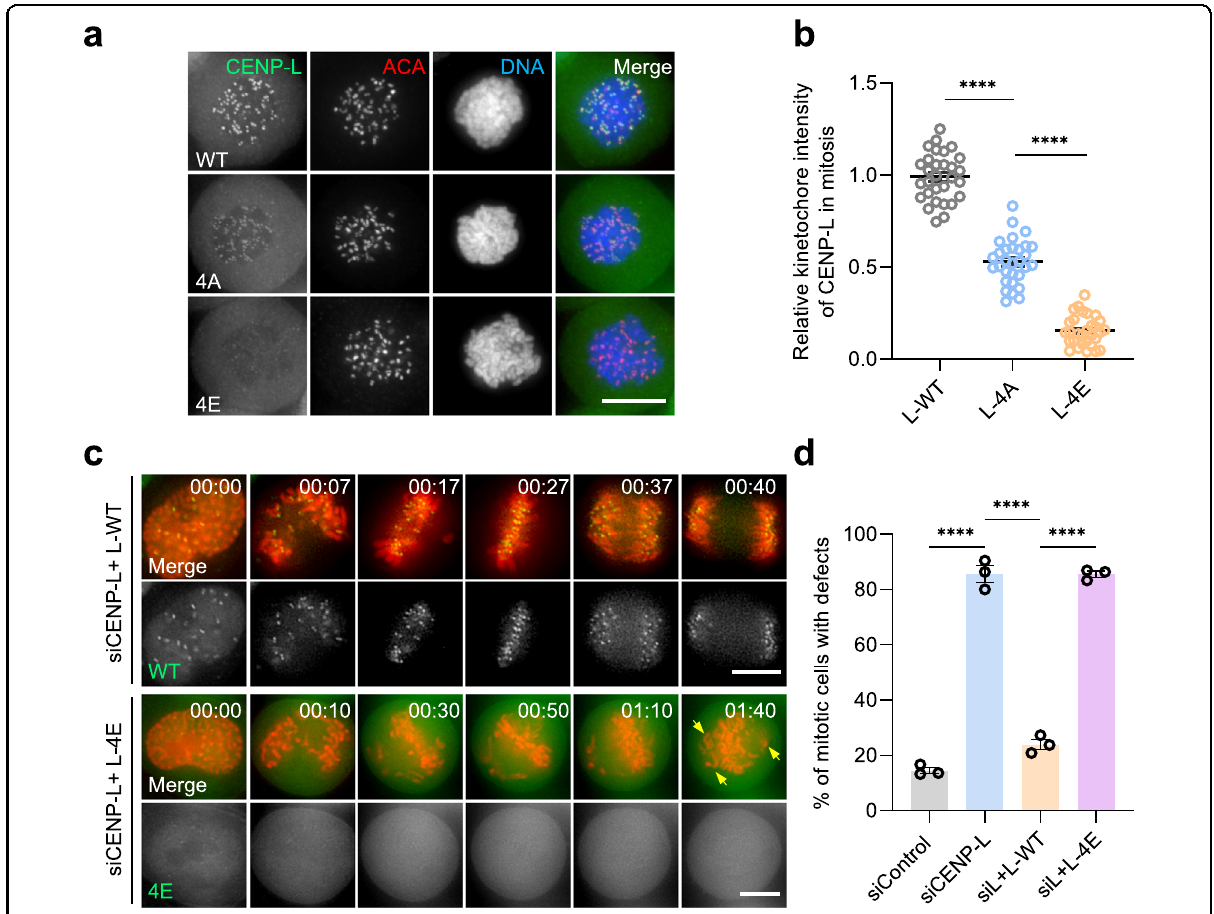
Fig. 4 CENP-L binding to DNA is essential for accurate chromosome segregation. a Representative immuno fl uorescence montage of HeLa cells expressing GFP-CENP-L wild type and DNA binding-de fi cient mutants. Scale bar, 10 µm. Note that K155/R306/K319/K321 determine CENP-L localization to centromere in mitosis. b Statistical analyses of centromere localization ef fi cacy of CENP-L wild type and mutants (4A, 4E). Data present means ± s.e.m. from three independent experiments of 30 cells. Ordinary one-way ANOVA followed by Tukey ’ s post hoc test was used to determine statistical signi fi cance. **** p < 0.0001. c Real-time imaging of HeLa cells with chromosome marked by H2B-mCherry and GFP-tagged CENP-L wild type and 4E mutant in the absence of endogenous CENP-L. Note that 4E mutant caused mitotic arrest with chromosome alignment defects. Scale bar, 10 µm. d Quanti fi cation of mitotic phenotypes in cells expressing CENP-L 4E mutant after induction of endogenous CENP-L knockout as in c